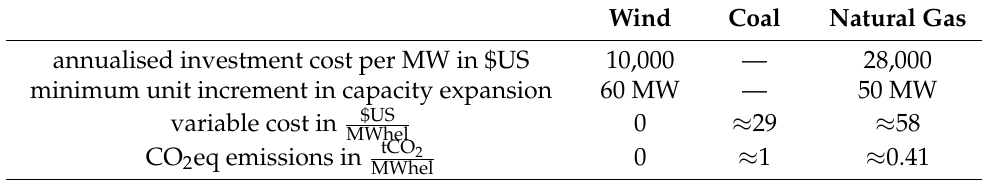
Table 3. Parameters specific to each energy